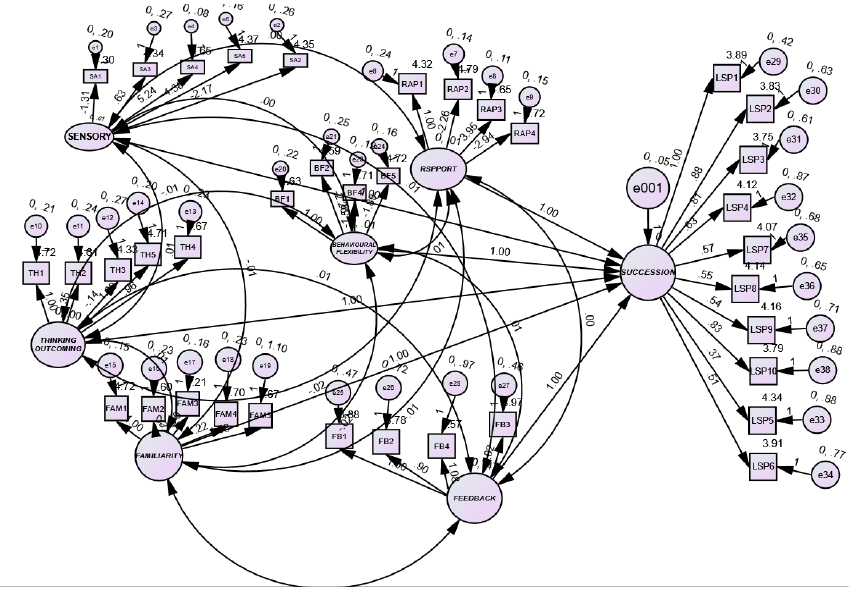
Figure 8. The Interpretive Structural Equation Model After